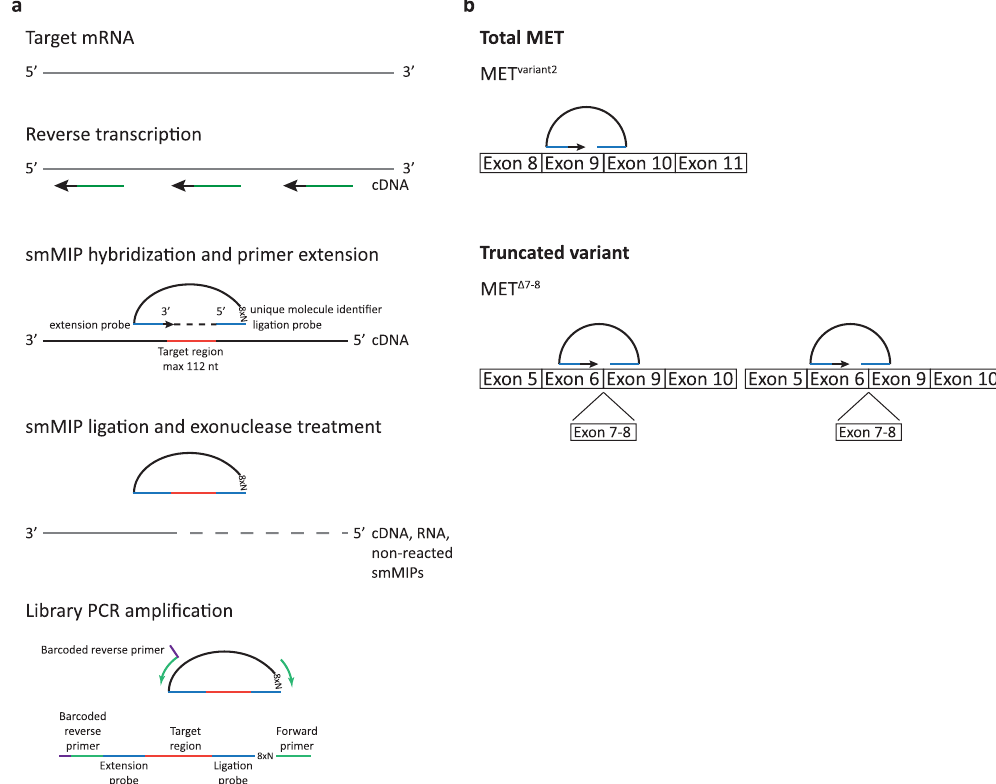
Figure 1. Quantitative detection of transcript splice variants using smMIPs. ( a ) Schematic overview of the method. mRNA is reverse transcribed into cDNA using random primers. SmMIP probes hybridize to the target region of interest, leaving a gap of ~112 nucleotides. The gap is filled by primer extension and ligation, whereafter all remaining linear smMIPs, RNA and cDNA are removed by exonuclease treatment. All circular smMIPs are PCR amplified using a unique barcoded reverse primer for each sample. Resulting reads are mapped against reference transcriptomes, normalized to the total read count within a sample (FPM), and averaged per transcript variant. ( b ) Design of smMIP probes. To determine the total expression of a gene, smMIPs were designed against shared parts of the transcript of interest (upper panel). For specific detection of splice variants smMIPs were designed to target variant-specific exon-exon junctions (for example the exon6–9 junction for MET Δ 7-8 ), either covering the junction with the gap or the ligation/extension probe (lower panel left and right, respectively). Note that for graphical representation, the figure is not to